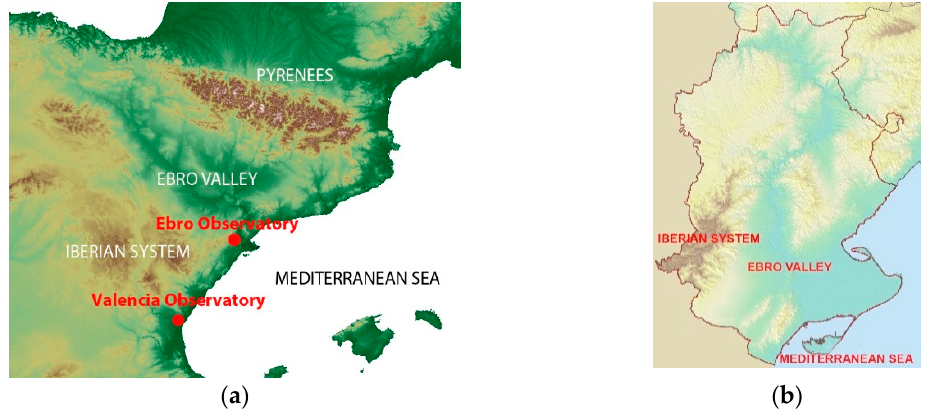
Figure 1. ( a ) Position of the two observatories. Ebro (40.82° N, 0.49° E) and Valencia (39.49° N, 0.47° W); ( b ) Relief map of the lower Ebro Valley. ( b ) Relief map of the lower Ebro